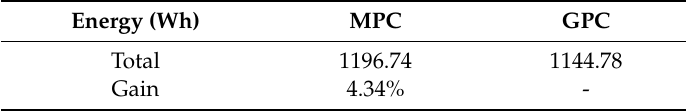
Table 4. Total energy consumption based on the predictive